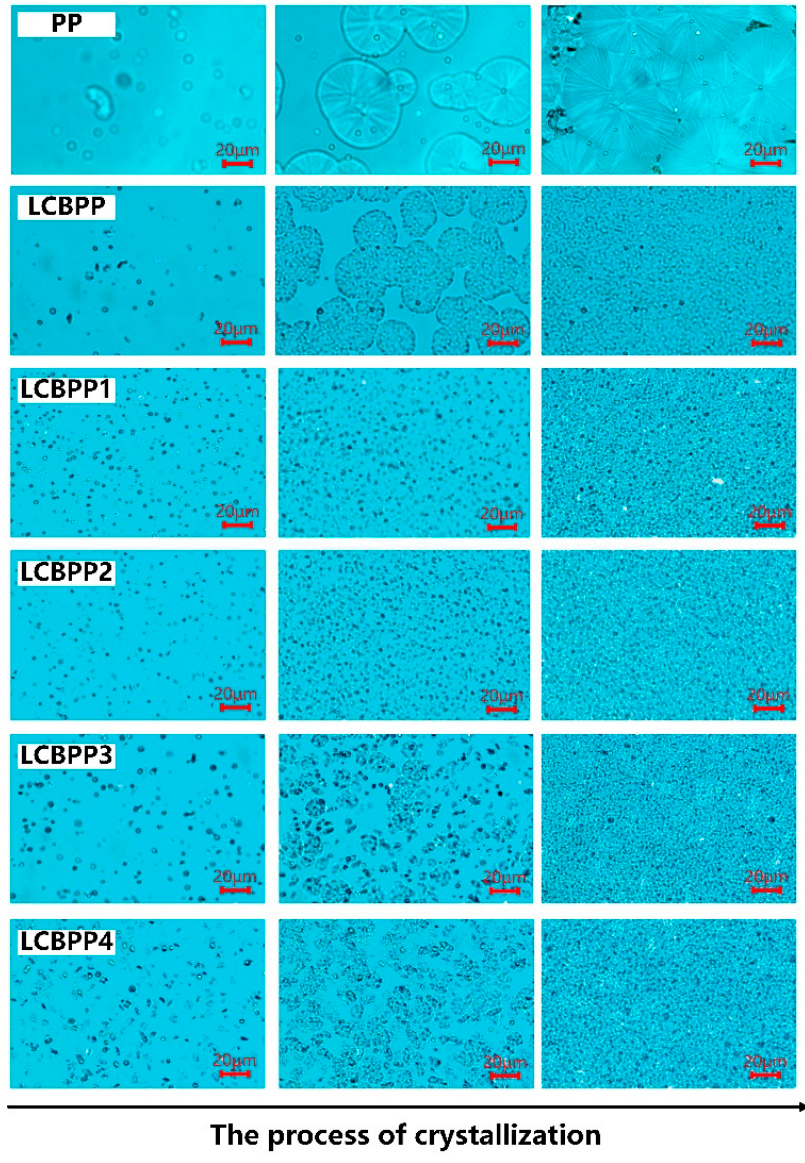
Figure 6. Crystalline morphology comparison of PP, LCBPP and modified films with α nucleating agents added during the process of crystallization.